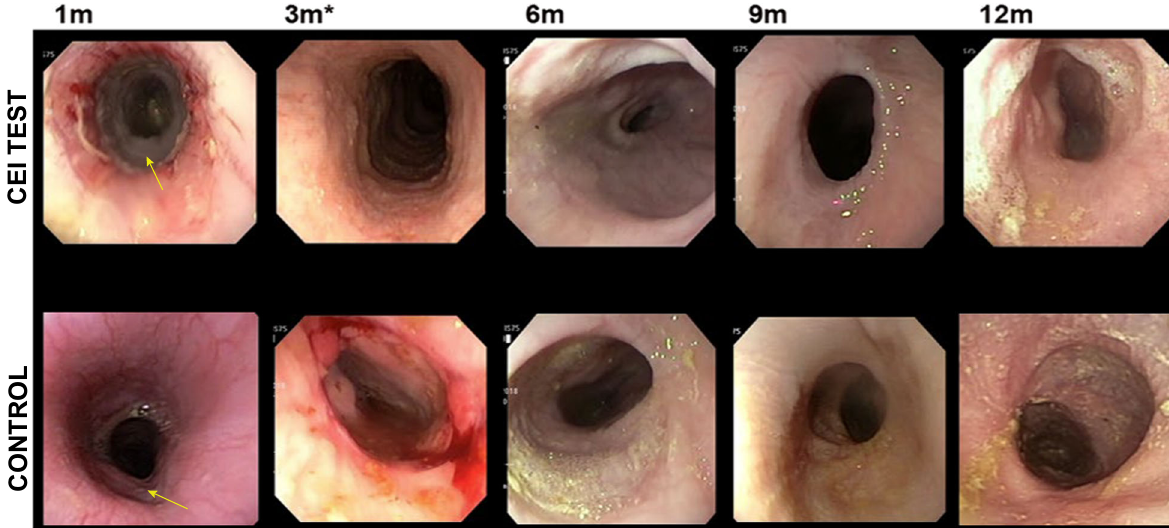
Fig. 2 Endoscopic evaluation of the implant at multiple time points. Endoscopy images taken at 1 month (all animals), 3 months (90 day and 365-day cohorts), and then sequentially at up to 12 months (365-day cohort). CEI implant recipients ( a ); surgical control cohort ( b ). The images illustrate that at 1 month (arrow) there is still a regenerating area in the test animal. By 3 months (asterisk; control and test animals) the epithelium appears to be regenerated as evident by the smooth glossy surface that persisted up to the 12 month time point in the long term cohort (365